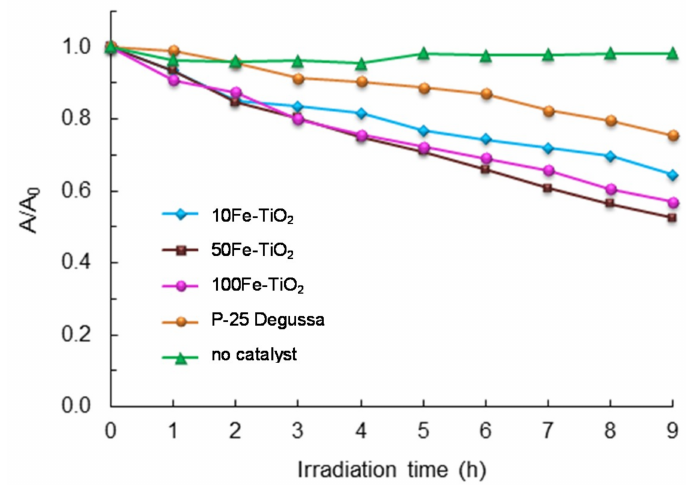
Figure 6. Photocatalytic degradation of Reactive Violet 5 (RV5) in the absence and presence of di ff erent catalysts (c 0 RV5 = 30 ppm; pH = 7.2; catalyst load = 3 g / L). A is the absorbance of the dye solution at 560